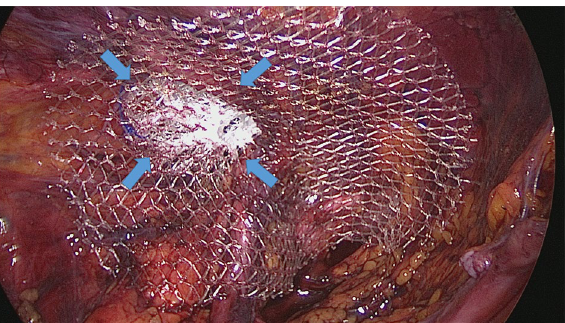
Figure 5. A 40 mm Proflor E, positioned in fixation free fashion, squeezed within the left sized indirect hernia opening achieves a complete defect obliteration. The flat part of the hernia device completely covers the medial and supravesical inguinal fossae as well as the femoral area.